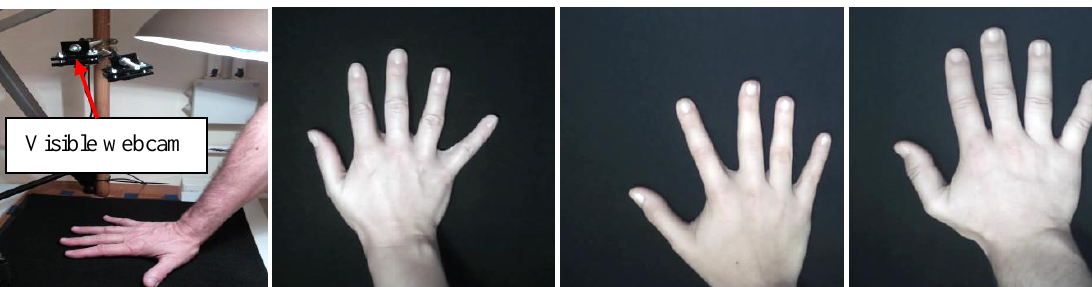
Figure 2. Hand dorsum visible acquisition system (figure on the left) and examples of visible hand images from three different users (three figures on the right).